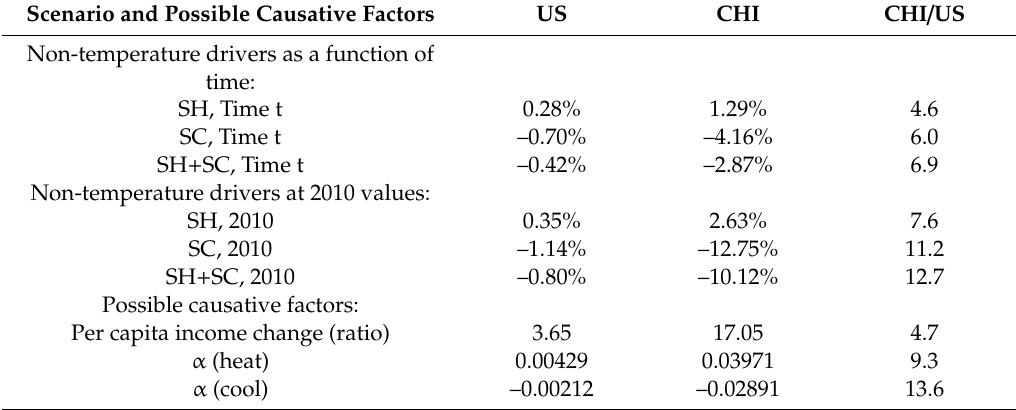
Table 5. USA and CHI economic impact (in percent of GDP) of heating and cooling at 3 ◦ C GMST increase from 2000, for two scenarios: non-temperature drivers are 1) a function of time, and 2) at 2010 values. Bottom rows are possible causative factors: ratio of change in per capita income from 2000, and parameters α (heat) and α (cool). The CHI / USA ratio is in the last